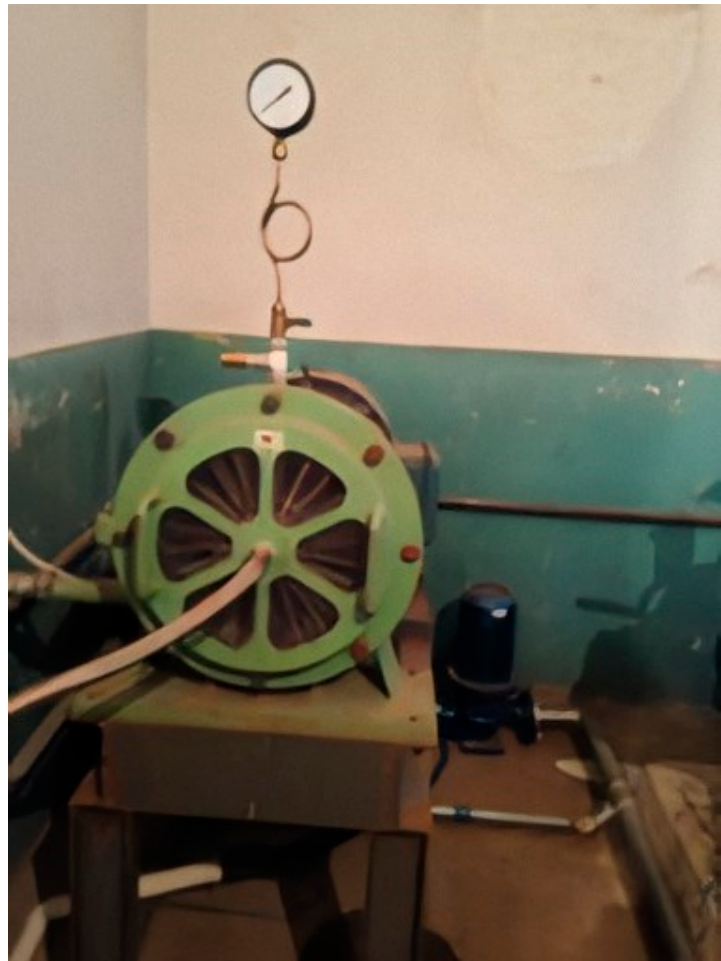
Figure 2. Rotating disc test rig.